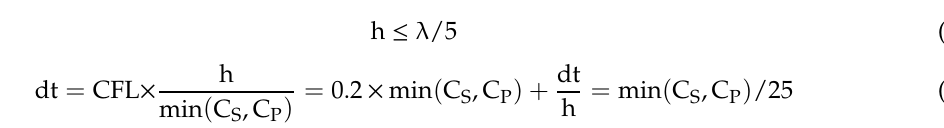
Table 1. Material properties of the concrete core and steel tubular of CFST.